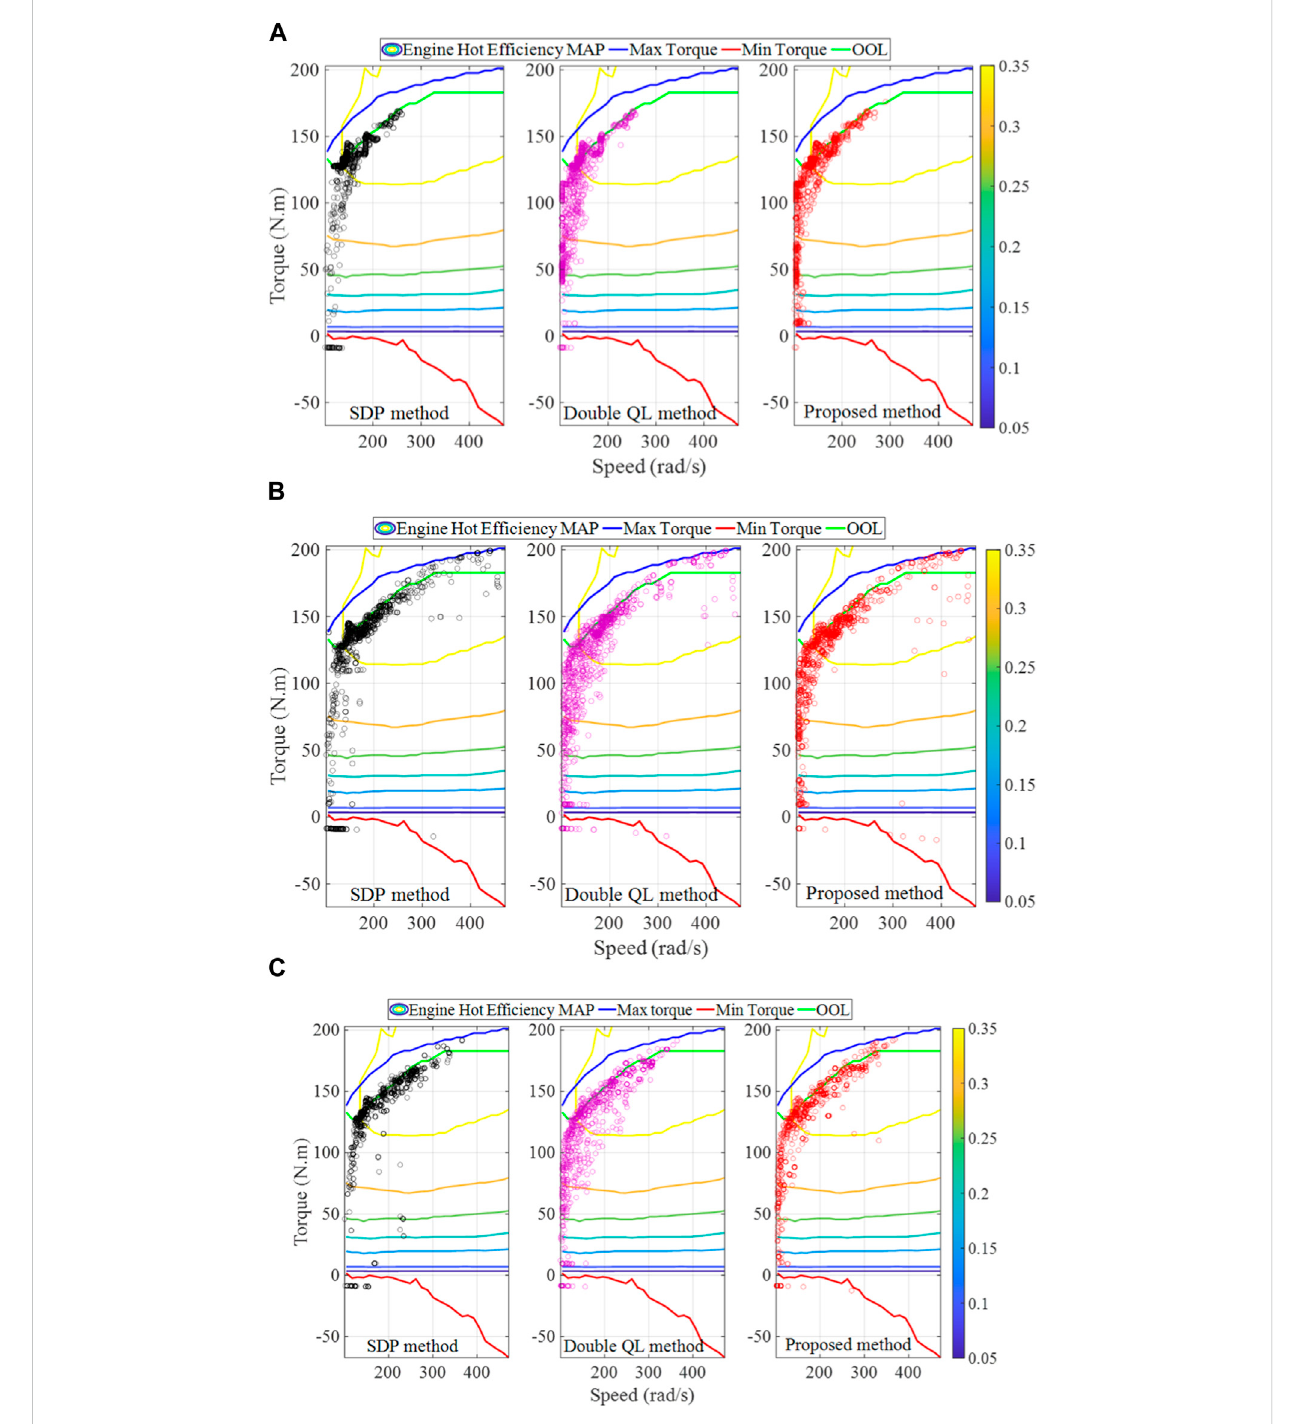
FIGURE 14 Engine ef fi ciency of different methods under different driving cycles: (A) Cycle 1; (B) 5 KM1; and (C) 12